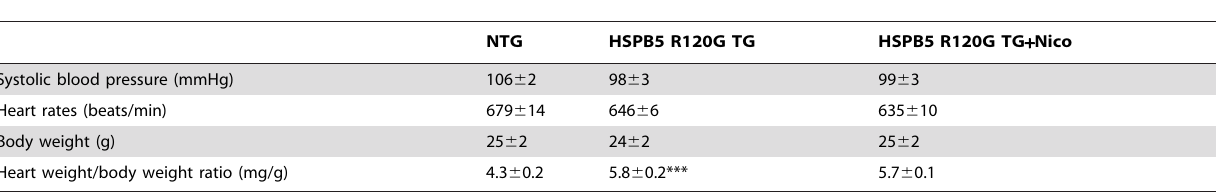
Table 1. Heart weight and blood pressure.